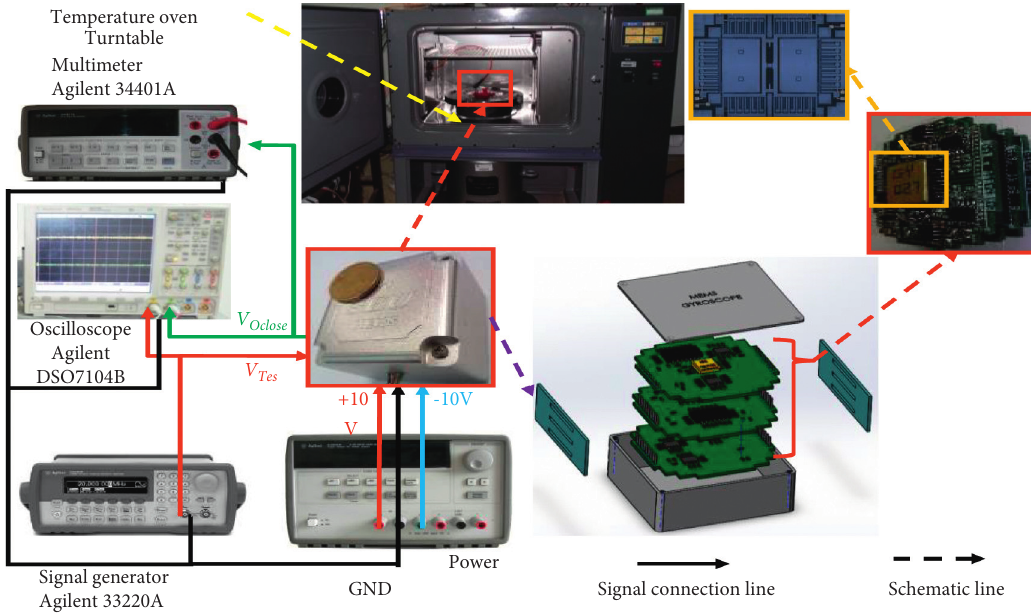
Figure 8: The equipment of temperature